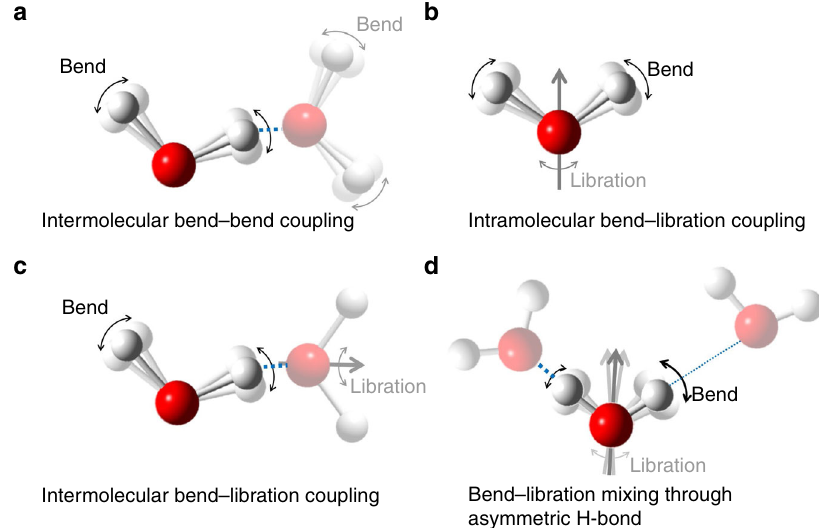
Fig. 1 Types of the vibrational couplings of the H – O – H bending mode. a Intermolecular bend-bend coupling of different water molecules. b Intramolecular bend-libration coupling within a single water molecule. c Intermolecular bend-libration coupling of different water molecules. d Bend-libration mixing induced by the asymmetric hydrogen-bond (H-bond) strengths. Hydrogen and Oxygen atoms are represented by white and red spheres, respectively. The gray arrows represent the H – O – H angular bisector direction. Strong (weak) hydrogen-bonds are represented by thick (thin) broken blue